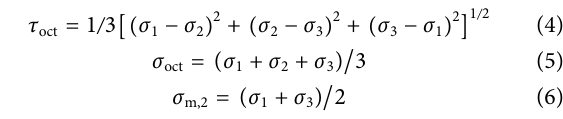
Frontiers in Earth Science |